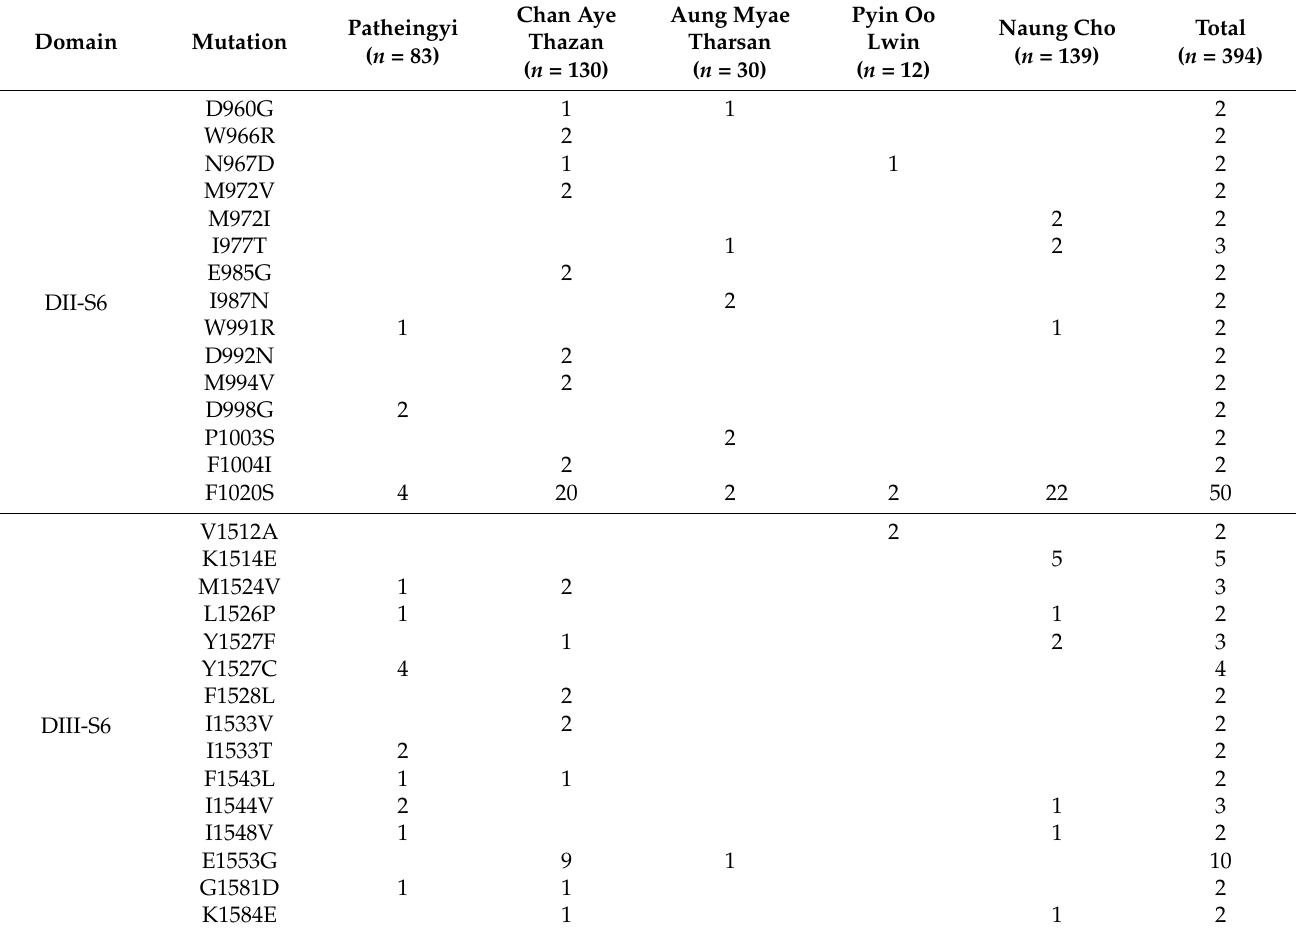
Table 1. Minor mutations found in vgsc DII-S6 and DIII-S6 of Myanmar Ae. aegypti .